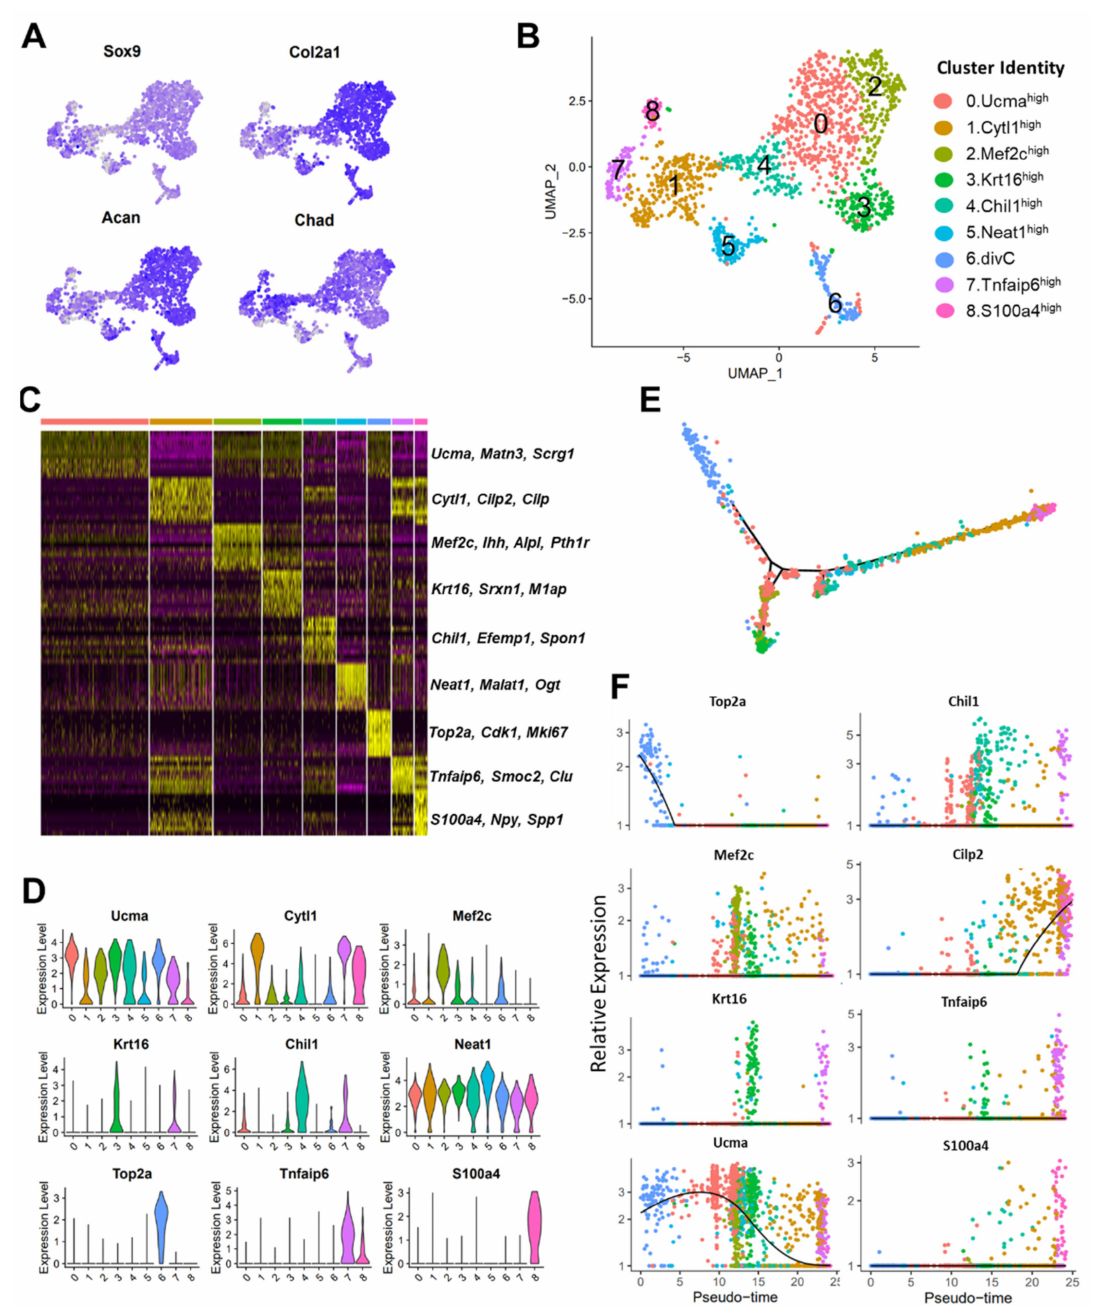
Figure 3. Characterization of chondrocyte subtypes. ( A ) Feature plots showing the expression of key chondrocyte markers. Blue: high expression, grey: low expression. ( B ) UMAP plots of various chondrocyte subtypes in mouse knee joints. Colors indicate clusters of various cell types with distinct gene expression profiles. ( C ) Heatmap showing the scaled expression of top genes differentially expressed in each cluster. ( D ) Violin plots showing the expression of selected markers of various chondrocyte subtypes. ( E ) Monocle pseudotime trajectory colored based on chondrocyte clusters in ( A ). ( F ) Expression of chondrocyte subtype markers on a pseudotime scale (colored based on clusters in ( A